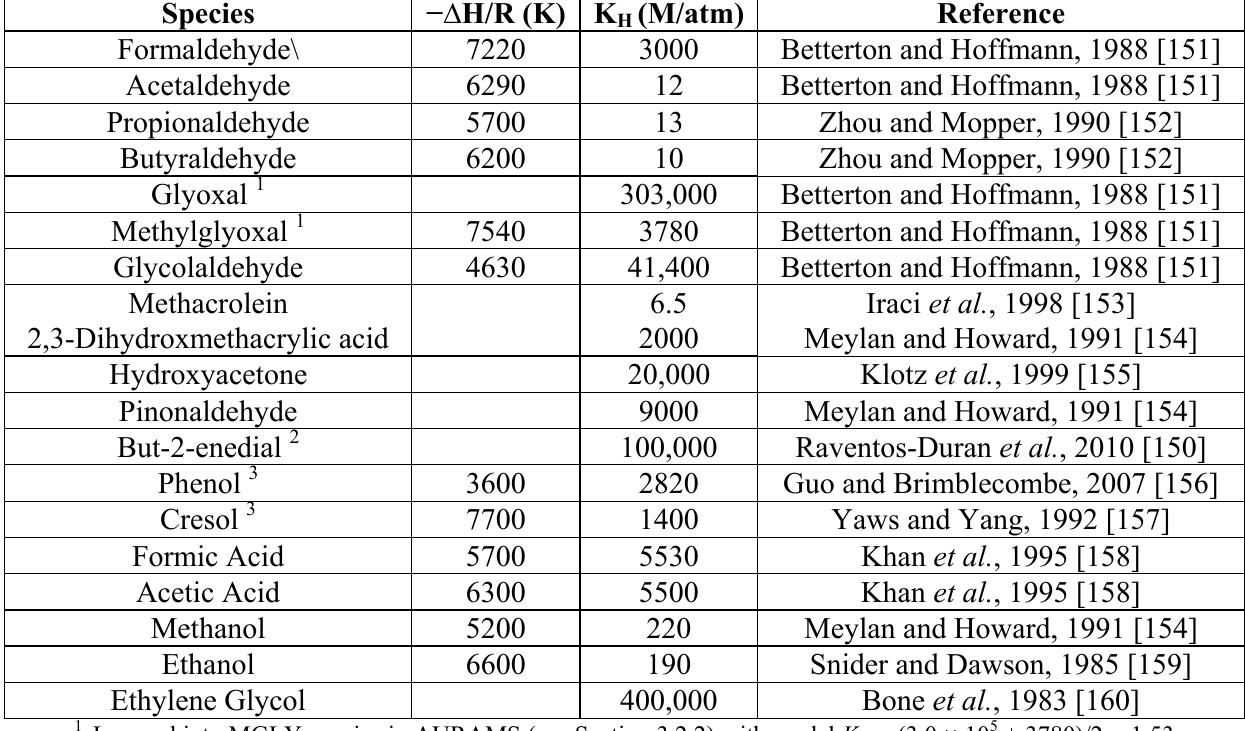
Table 2. Effective Henry’s law coefficients for the dissolution of several organic